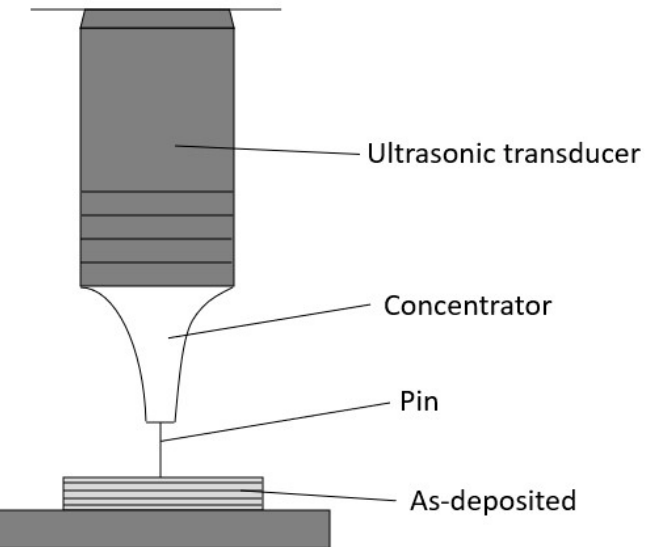
Figure 4. Schematic diagram of the UIT process.